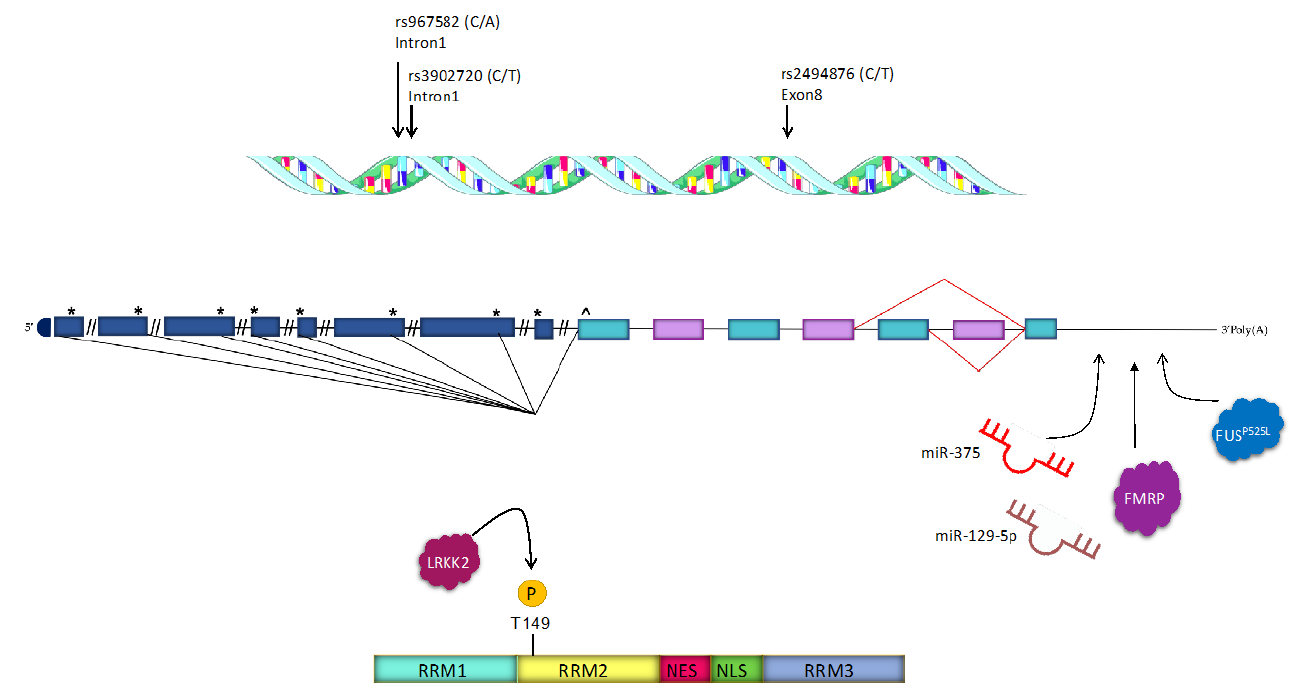
Figure 1. Schematic representation of HuD gene, mRNA, and protein. Top, a schematic representation of the ELAVL4 gene in which the PD-linked SNPs are indicated. Middle, a schematic representation of HuD mRNA isoforms, showing coding exons (green and purple rectangles), alternative non-coding exon 1 (blue rectangles), and the favored (ˆ) versus putative alternate translation start site (*). MicroRNAs and RBPs interacting with the 3’UTR are also displayed. Bottom, schematic diagram of HuD protein domains and the post-translational modification involved in PD. This figure was drawn using the vector image bank of Servier Medical Art